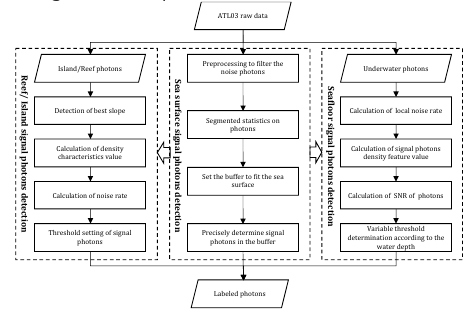
Figure 1. Flowchart for the AMSRLC